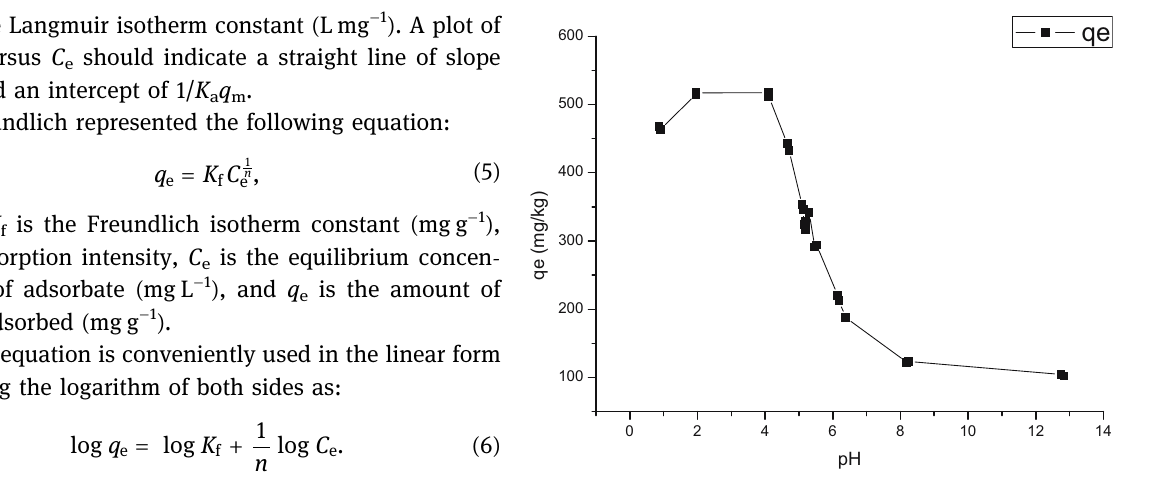
Figure 1: Molybdenum adsorption in fl uenced by pH of an equilibrating solution of Mo = 0.292 mmol L − 1